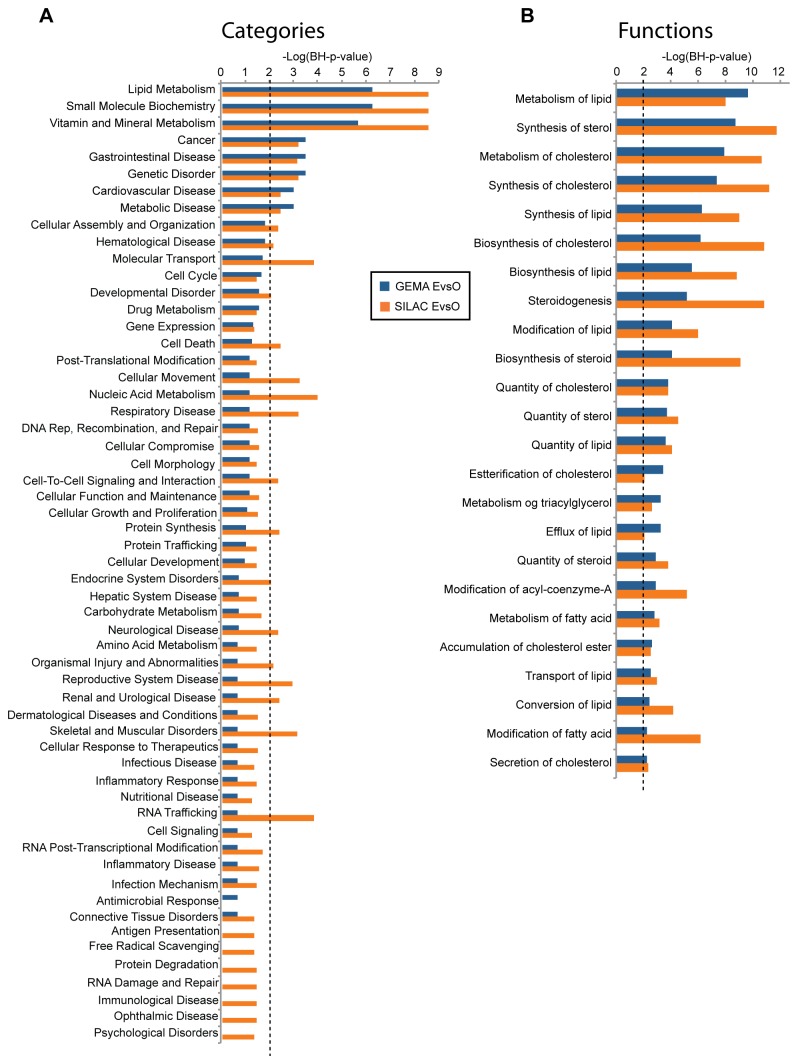
IPA categories and functions specifically perturbed by EA as compared to OA, comparing GEMA and SILAC data.
Panel
A displays perturbed IPA categories. The y-axis reports the significances of the perturbation and is plotted as minus log of the BH multiple testing corrected p-value calculated by IPA based on the specific data set. Panel
B displays the 24 significantly perturbed functions found in the top three IPA categories for both SILAC and GEMA. For both panels, the dotted line is the threshold BH-p-value 0.01, with orange bars representing the GEMA data and the blue bars representing the SILAC data.